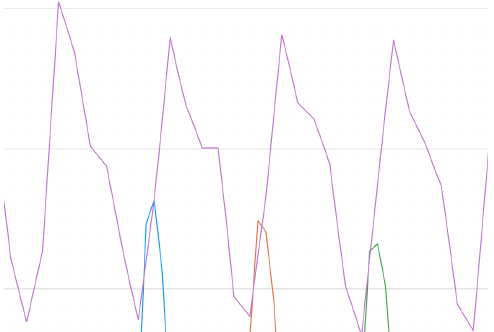
Figure 9: Hardware AES engine input byte pair correlation (4+5, 9+10, 14+15), with oversampled probability trace showing corresponding iterations of software polling